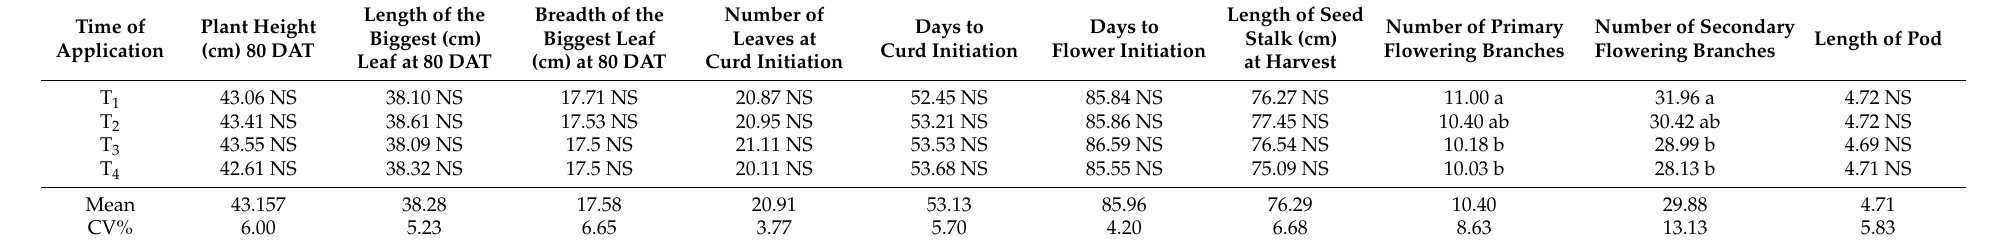
Table 2. The main effect of time of application on phenological traits in BU